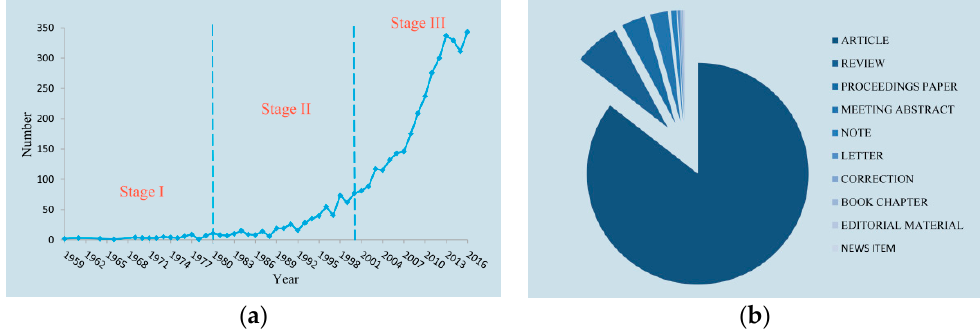
Figure 1. The status of publications. ( a ) Publication counts during 1959–2016 per year; ( b ) Types of publications.